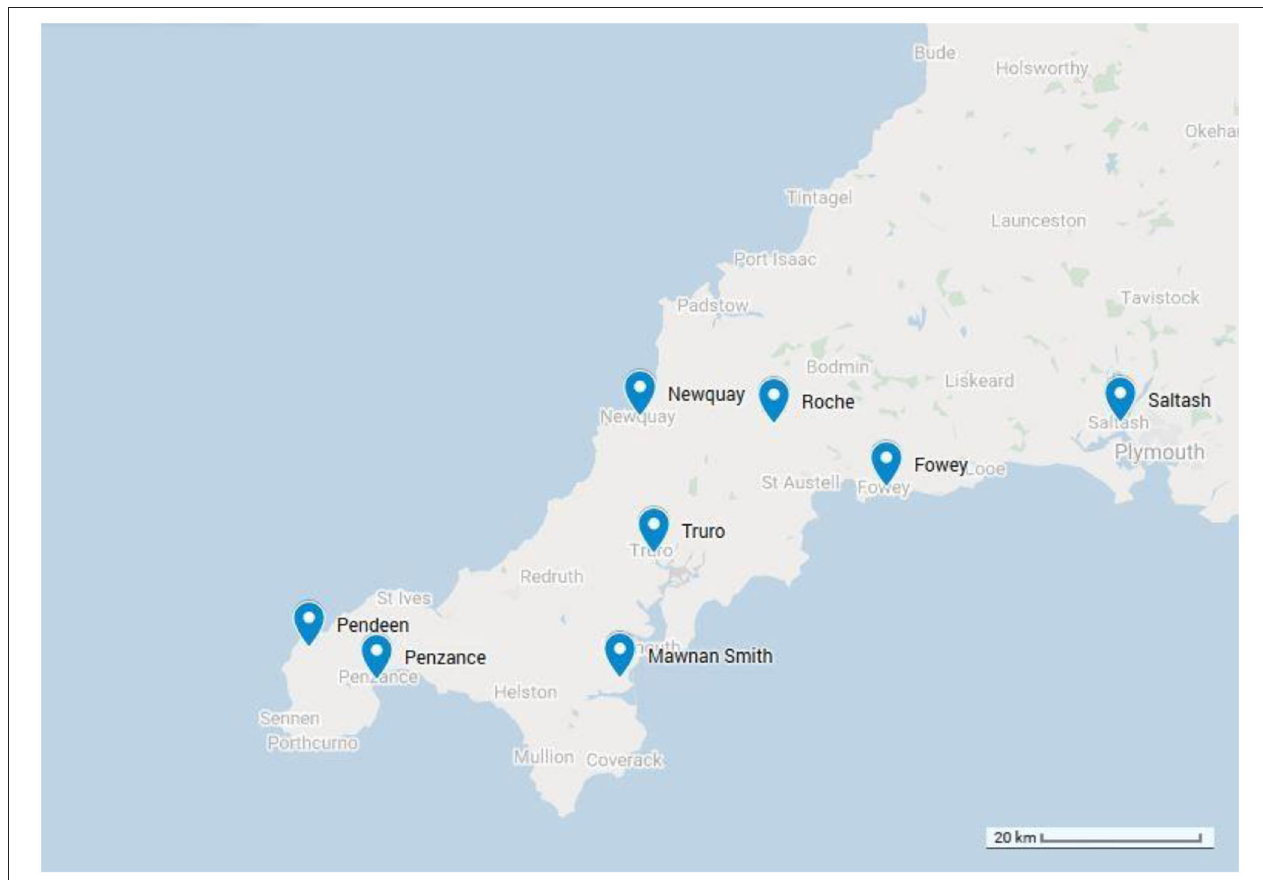
FIGURE 1 | Focus group locations within cornwall, UK. Map data © 2020 Google.